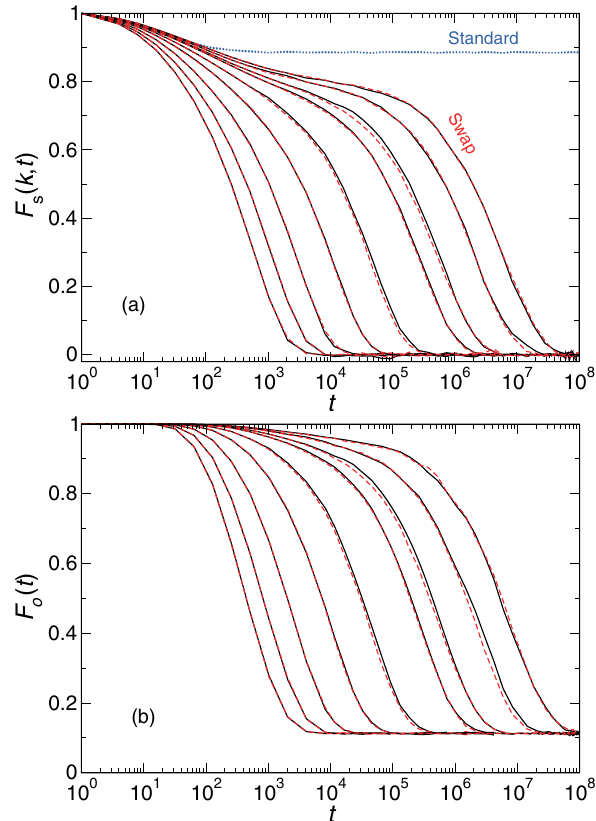
FIG. 4. Swap dynamics in a soft repulsive system of non- additive particles studied in Sec. IV C with ϵ ¼ 0 . 2 . (a) Self- ð k; t Þ computed, respectively, on the first incoherent scattering F s (solid lines) and second (dashed lines) halves of the simulation run. Results for standard dynamics without swap for the lowest temperature are shown with a dotted line. (b) Collective overlap ð t Þ . In both panels, temperatures are correlation function F o T ¼ 0 . 25 , 0.175, 0.125, 0.092, 0.075, 0.065, 0.062, 0.058, and 0.0555, from left to right. Swap Monte Carlo simulations fully decorrelate both single-particle and collective density fluctua- tions in a regime where standard Monte Carlo simulations may be fully